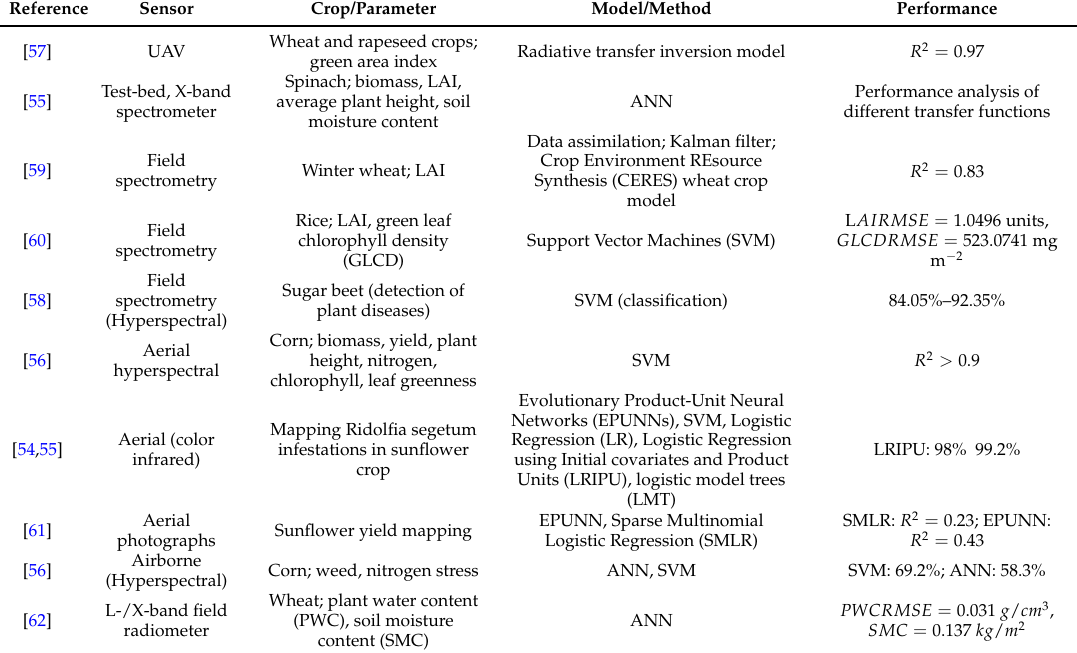
Table 2. Examples of machine learning applications for crop parameter retrievals using remote sensing